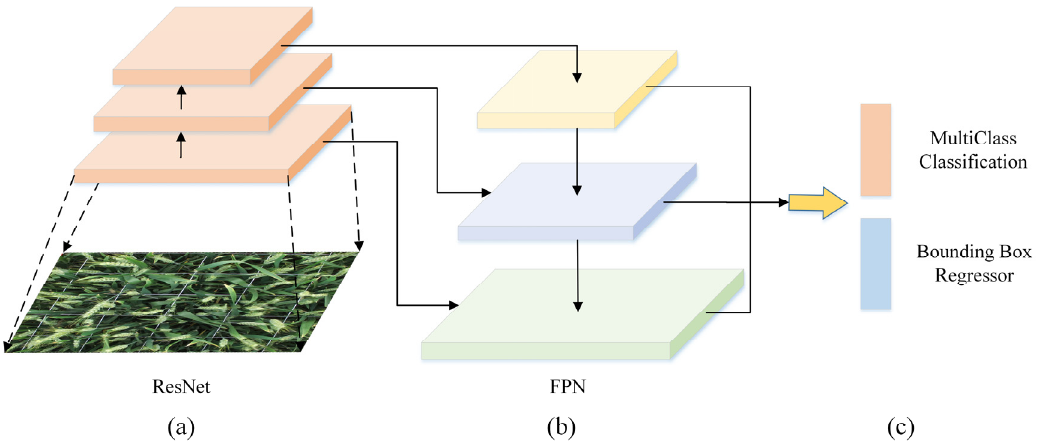
Figure 6. The structure of RetinaNet. ( a ) Backbone network; ( b ) decoder; ( c ) subnet).